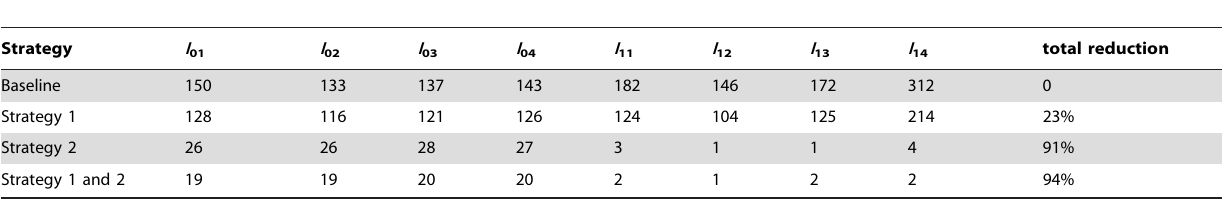
Table 3. Model-based forecast of the number of first-time infections ( I 0 a )and recurrent infections ( I 1 a ) for the first age groups ( a [ f 1,2,3,4 g ), and reduction of total infections in the pediatric population (0–19 years) compared with baseline (no intervention) at the end of 2023 under different population-wide intervention